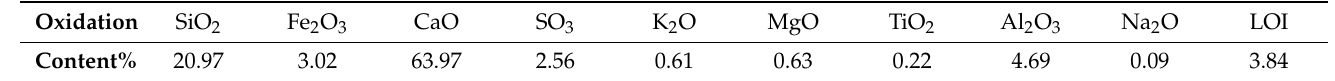
Table 1. Concrete composition in kg/m 3 . Table 2. Chemical composition of cement.